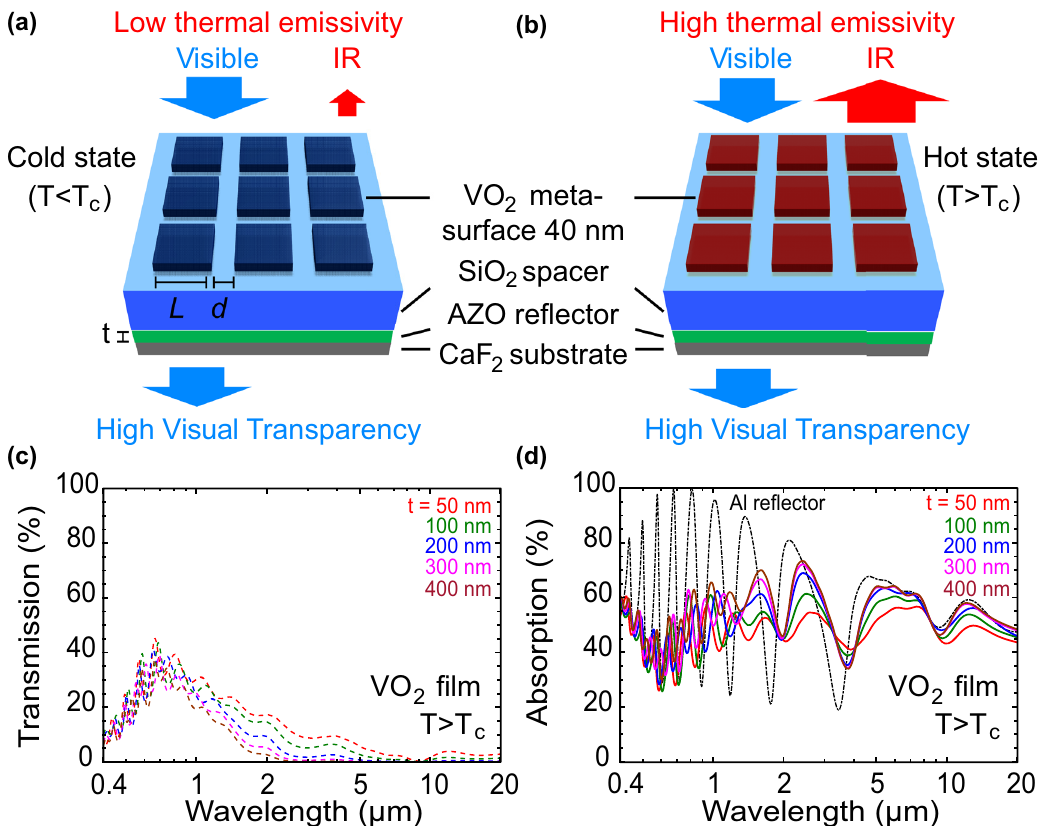
Figure1: OperationofsmartVO 2 metasurfacethermalemitter.(a)Coldstateschematic(b)hotstateschematic(candd)numericalsimulations of transmission (dashed lines, c) and absorption spectra (solid lines, d) for VO 2 thin fi lm thermal emitter in the hot state ( T > T C ) with AZO re fl ector thickness t ranging from 50 to 500 nm. Results for Al-re fl ector design are shown by dash-dotted line in d for